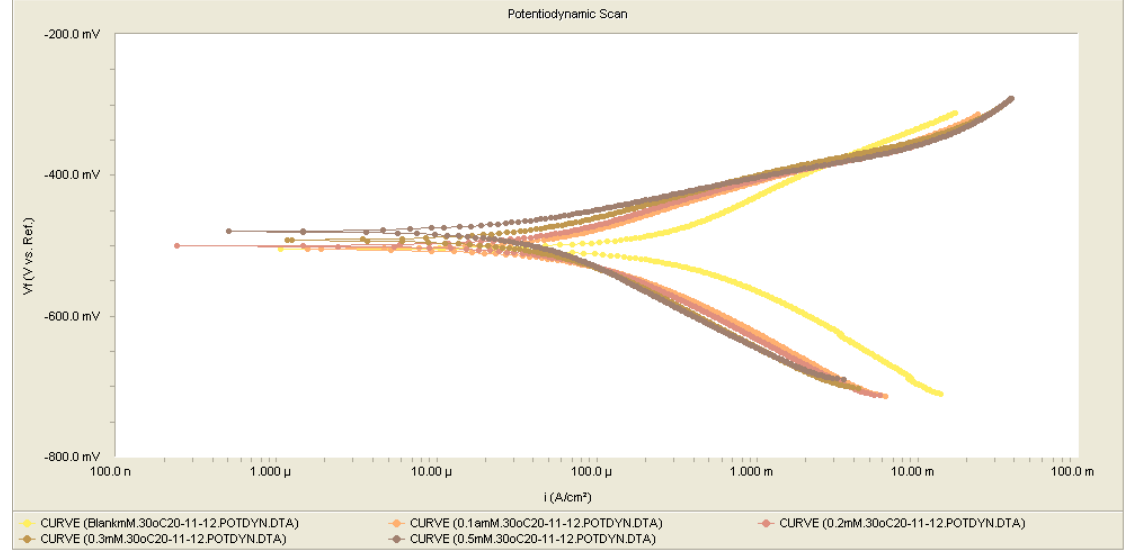
Figure 2. Potentiodynamic polarization curve for mild steel in 1.0 M HCl with various concentrations of DMPO at 30